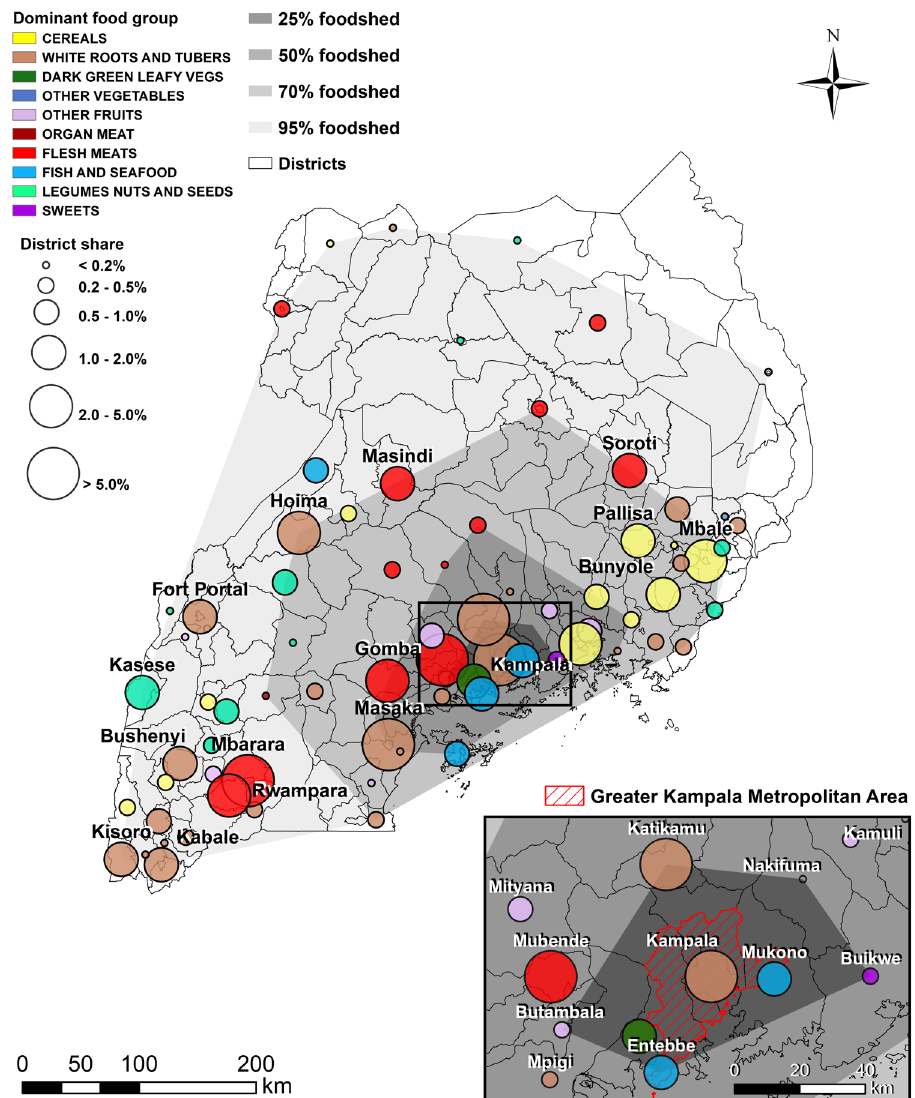
Fig. 2 Foodshed of consumers in Kampala. Polygons delineate the percentage of food that is provisioned within that area. The dots represent district share of the total foodshed (in terms of UGX/day). The dominant food group originating from each district (based on vendor data) is also shown. Food groups not shown in the legend were not dominant in any GKMA. While for most SECs the cumulative foodshed contribution steadily rises with distance from the city, the low-income newcomers have the most convex curve (starting at only 5.2% of their foodshed sourced within Kampala). Considering the signi fi cant differences in the food security and dietary diversity of that the differences in the cumulative size of the foodshed are limited. Supplementary Fig. 1 demonstrates the shape of the 50% foodshed for each SEC. The more local consumption of the established high-income households is shown clearly, with a very small polygon delineating the 25% foodshed for this SEC. The ‘ newcomers low income ’ are the only SEC where the 70% foodshed can be mapped at less than 200 km from Kampala. While for established clusters, ‘ white roots and tubers ’ dominate food group originating from within Kampala. This is in line with the observations in Supplementary Table 2, showing that the main